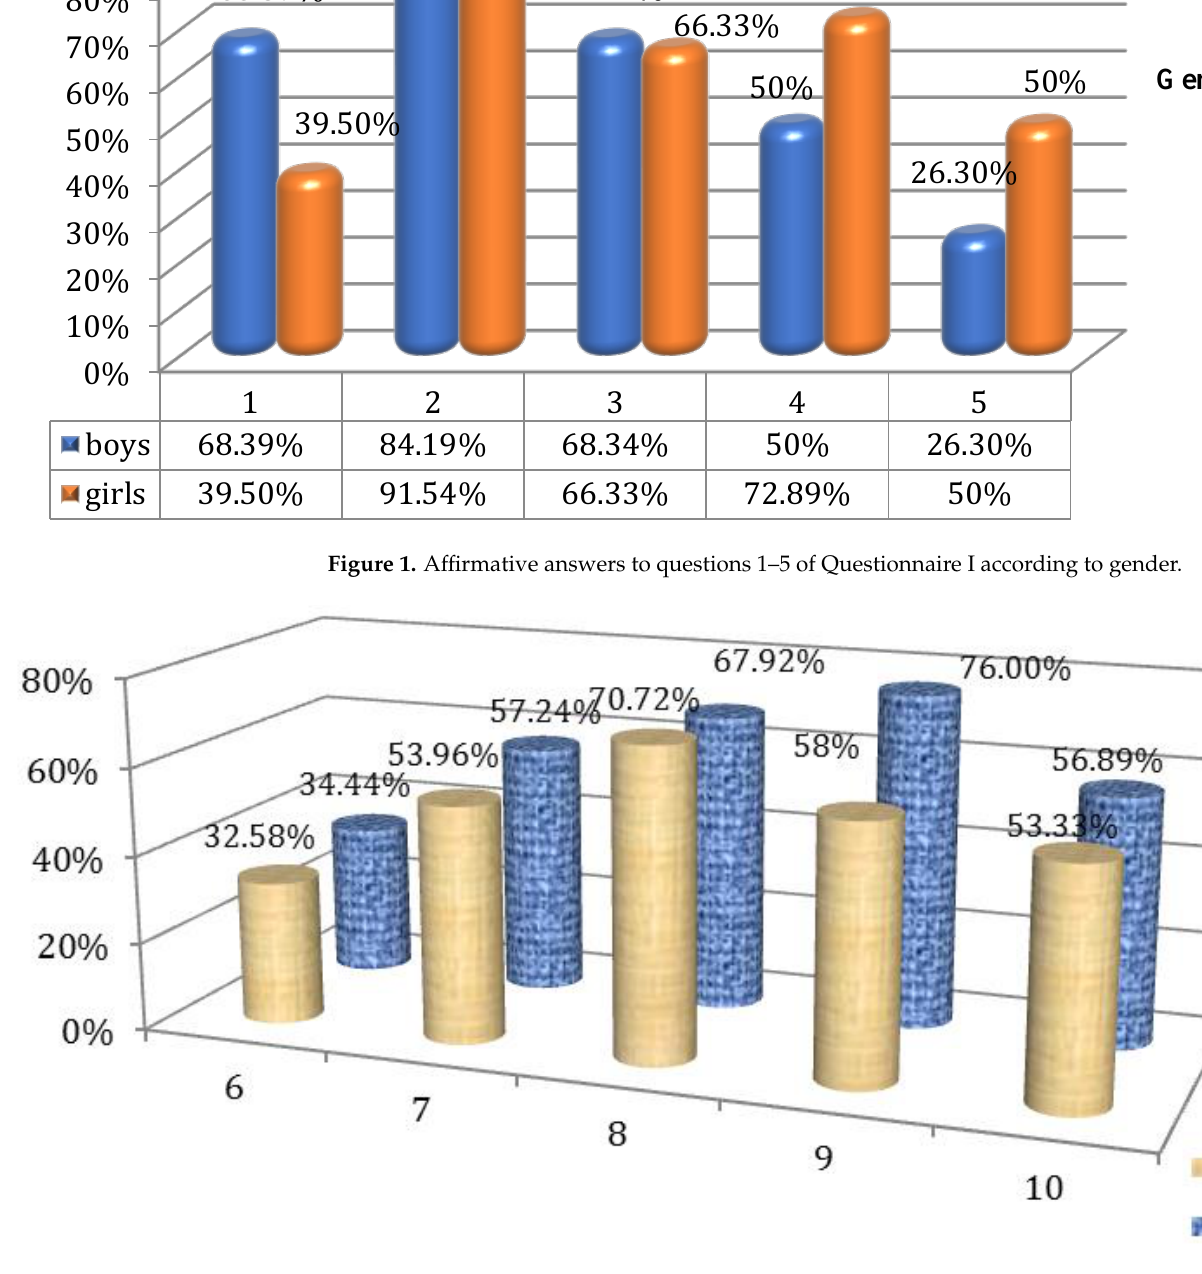
Figure 2. Affirmative answers to questions 6–10 of Questionnaire I according to gender. The statistical interpretation of the results of Questionnaire I according to the age of the patients is shown in Table